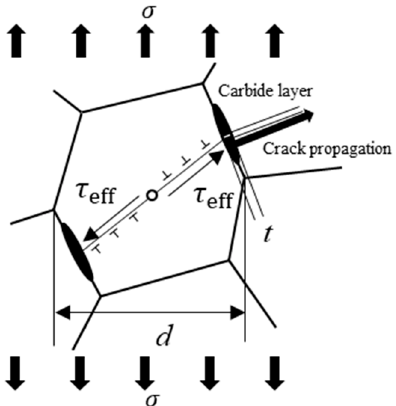
Figure 1. Brittle fracture micromechanism.